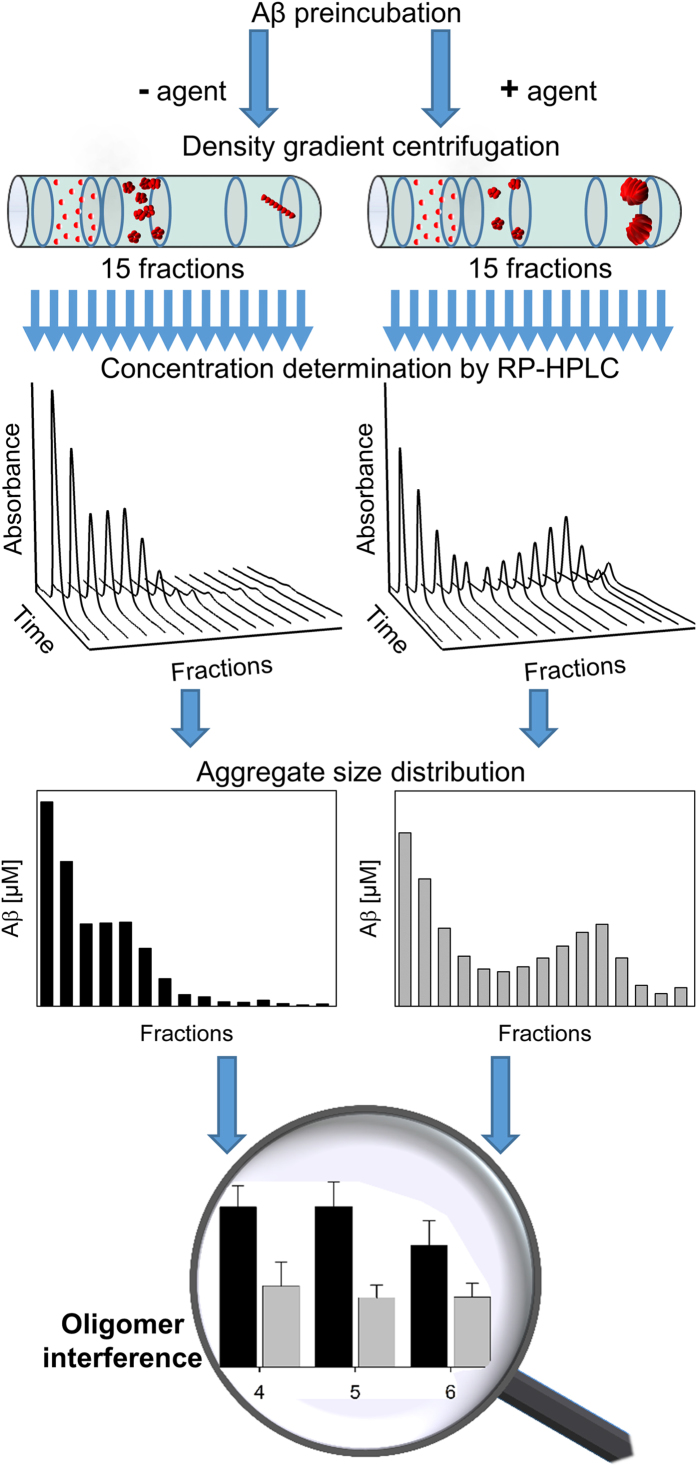
Scheme of the QIAD assay consisting of the following stepsi) preparation of Aβ(1–42) assemblies containing the target aggregate species by Aβ(1–42) pre-incubation; ii) incubation with and without the agent of interest; iii) separation of Aβ(1–42) assemblies by density gradient centrifugation and subsequent fractionation; iv) determination of the total Aβ(1–42) amount in each fraction by integrating the Aβ(1–42) absorption signal during RP-HPLC analysis and the concluding visualisation of the Aβ(1–42) oligomer removal. The drawing of the magnifying glass was drawn by O. Brener